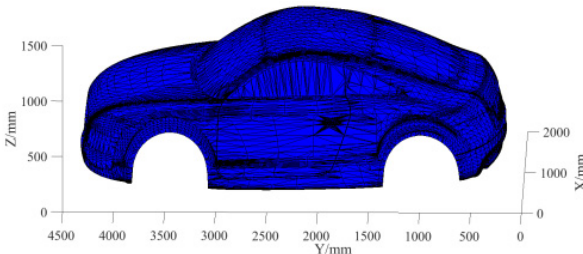
Figure 21. The STL analysis model of a car.